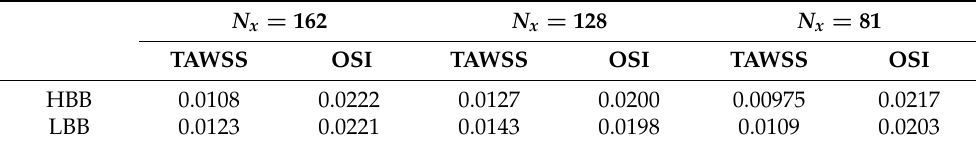
Table 5. TAWSS and OSI averaged in aneurysm (TAWSS is normalized with ρ U 2 /2). N x = 162 N x = 128 N x = 81 TAWSS OSI TAWSS OSI